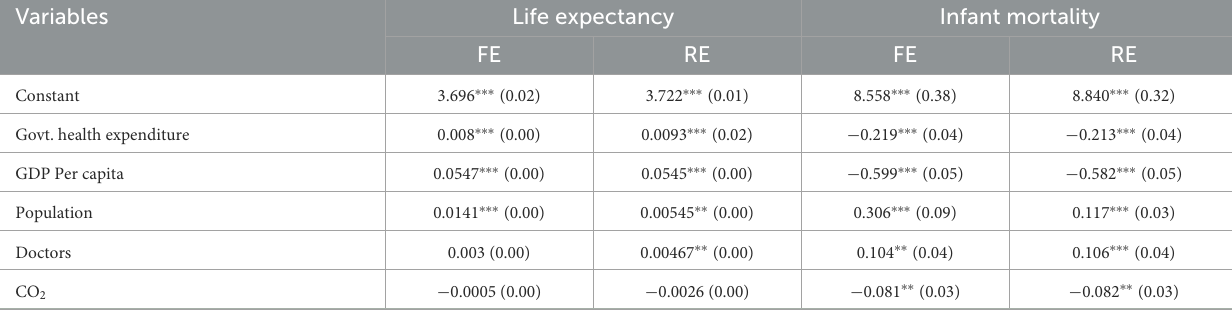
TABLE 2 Results of the fixed and random effect